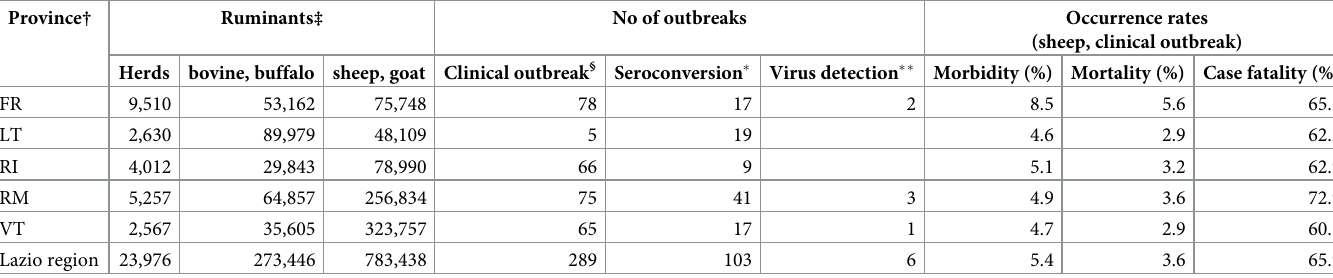
Table 1. Bluetongue susceptible animal population, number and type of outbreak and measures of disease occurrence in Lazio region in 2013/2014.